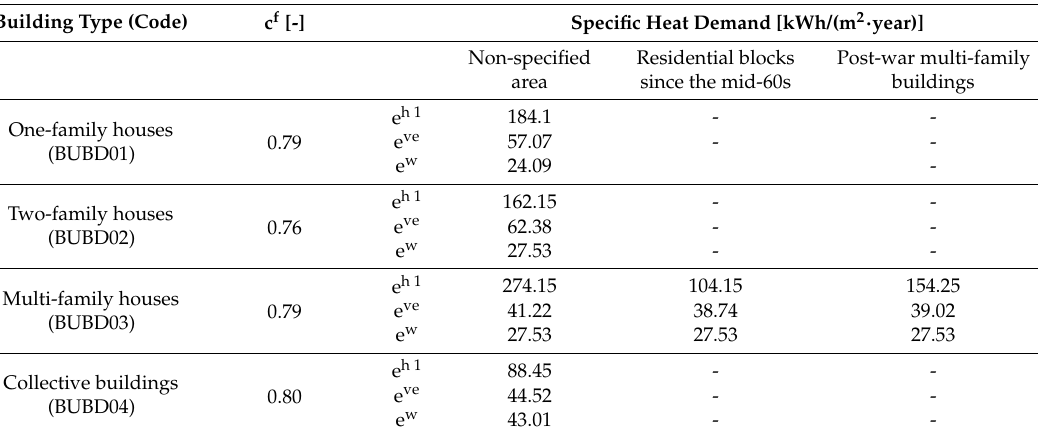
Table 1. Coefficients of residential buildings used in the case